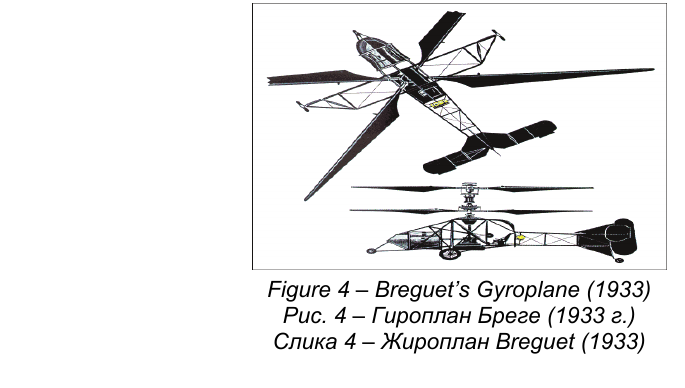
Figure 4 – Br е guet’s Gyroplane (1933) Рис . 4 – Гироплан Бреге (1933 г .) Слика 4 – Жироплан Br е guet